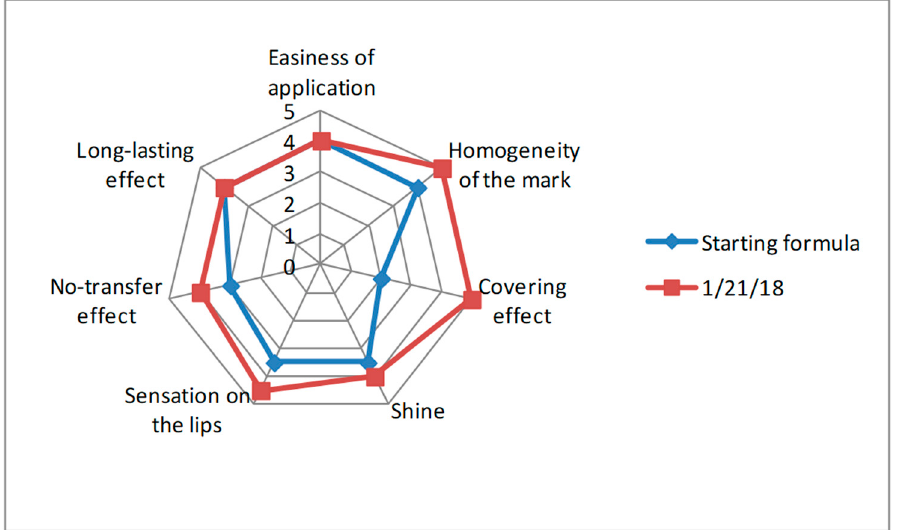
Figure 8. Initial formula vs. Ref. 1/21/18 (final formula).